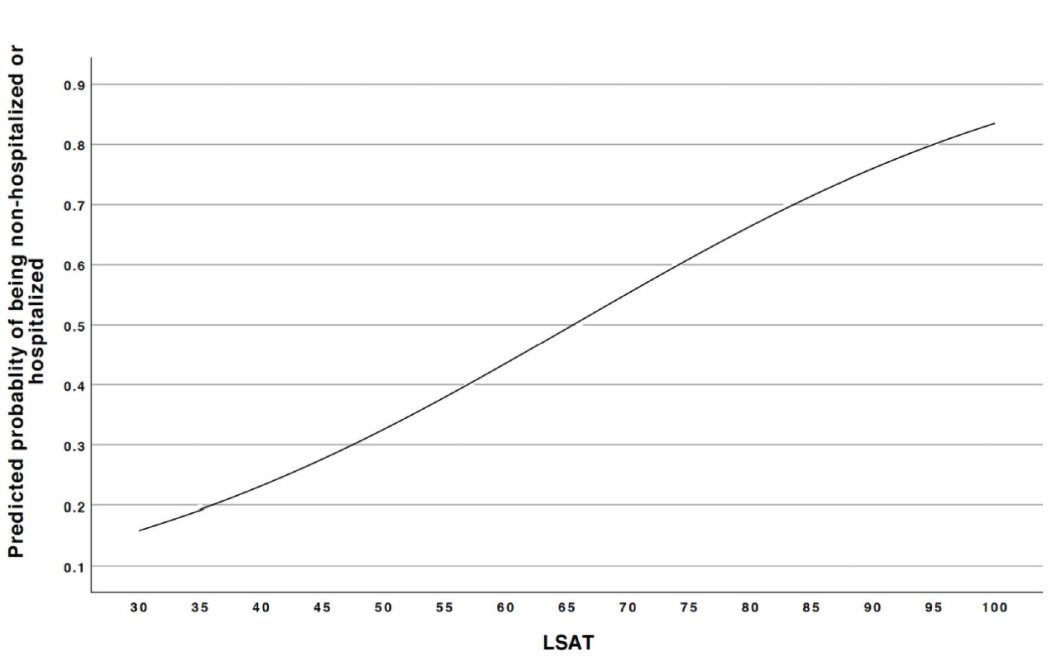
Fig 2. The predicted probabilities of being non-hospitalized or hospitalized of patients based on the LSAT. Prediction probability graph, where the X-axis illustrates mean LSAT. Y-axis illustrates the predicted probability for being non-hospitalized or hospitalized. LSAT, low oxyhemoglobin desaturation.